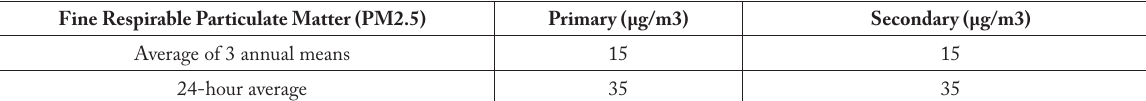
Table 5. National Ambient Air Quality Standards (NAAQS) of the USA [59].